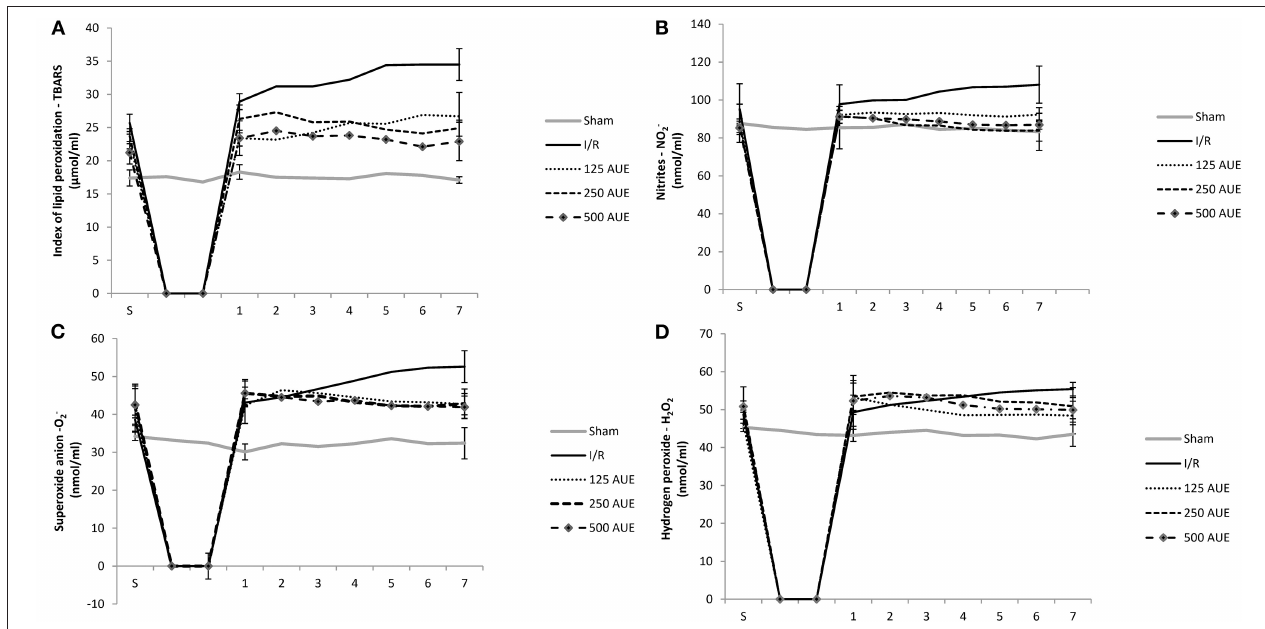
FIGURE 2 | Effects of consumption of increasing doses of AUE on the value of pro-oxidative markers in coronary venous effluent measured as an index of lipid peroxidation (TBARS) (A) , nitrites (NO 2 − ) (B) , superoxide anion (C) , hydrogen peroxide (H 2 O 2 ) (D) ( n = 50, 10 animals per group). Values are shown as mean ± SE.